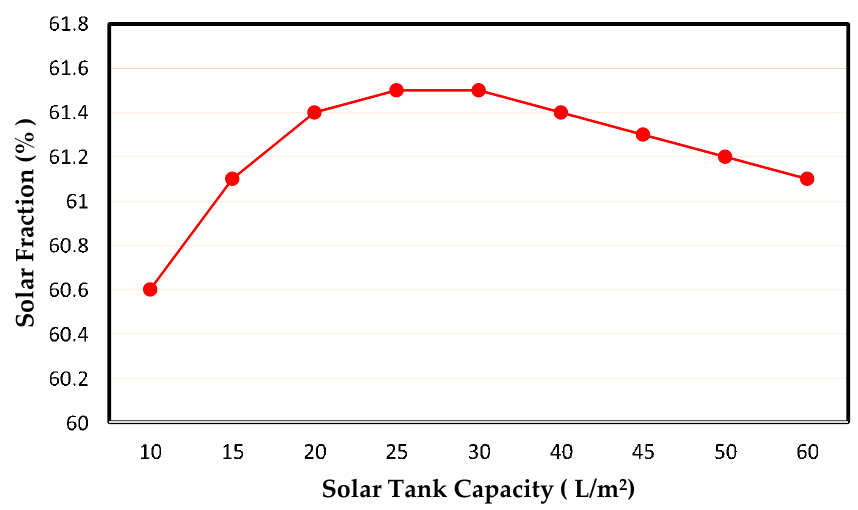
Figure 12. Solar coverage as a function of storage tank volume.